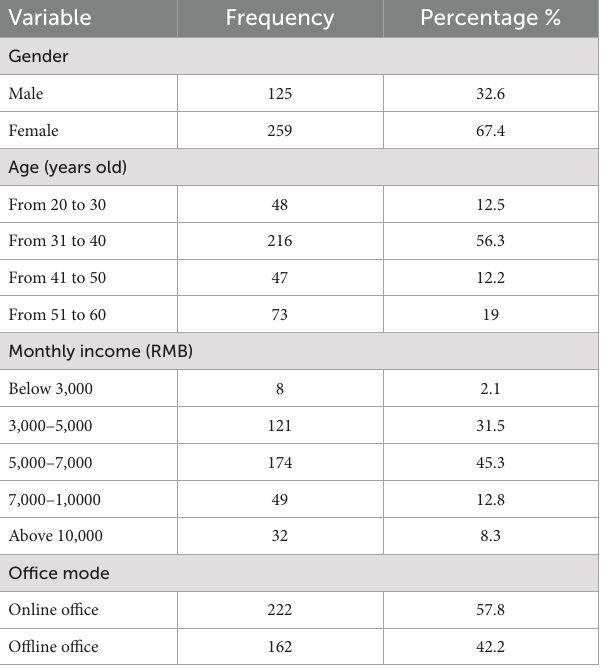
TABLE 1 Basic information of